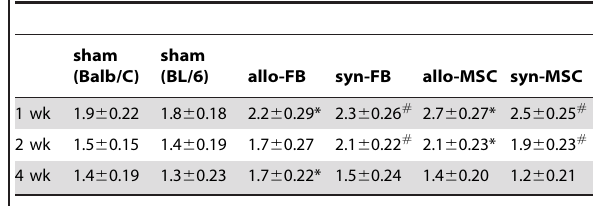
Table 1. Number of cells per wound ( 6 10 6